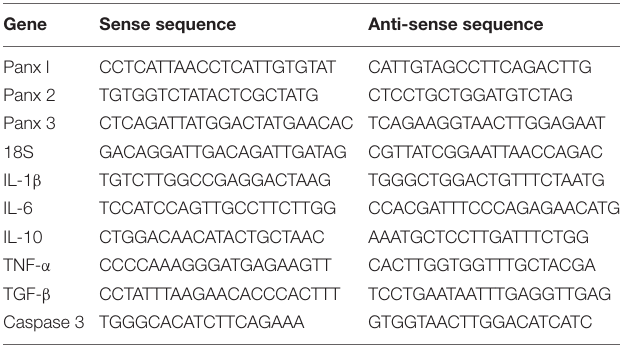
TABLE 1 | qPCR primers used in our study.